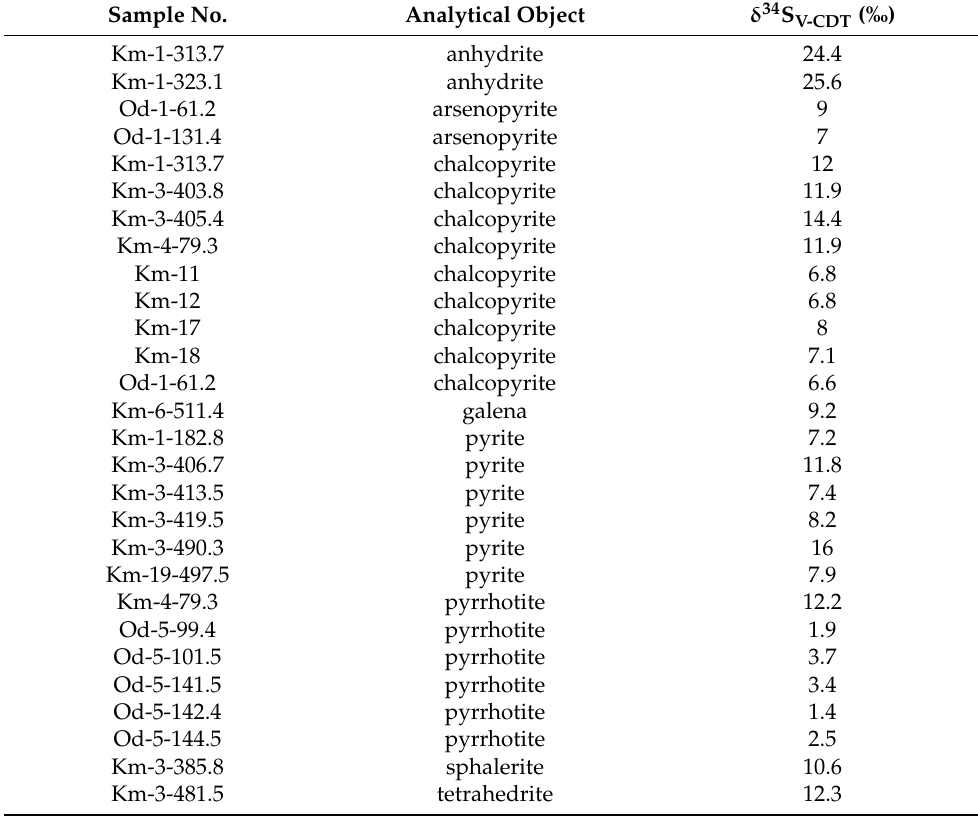
Table 1. Sulfur isotopic composition of sulfide minerals from the Kultuma